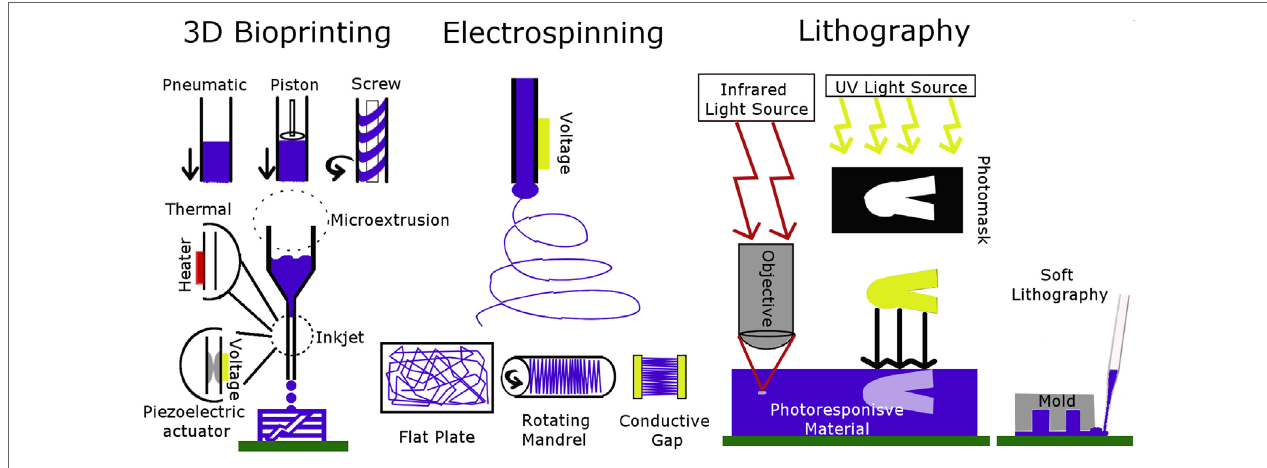
FiGURe 2 | Schematic of 3D bioprinting, electrospinning, and lithography techniques. The type of 3D bioprinter is chosen based on biomaterial rheological properties. Electrospun fibers are patterned by changing the collector. Lithography patterning is done by adjusting light-based techniques or using a